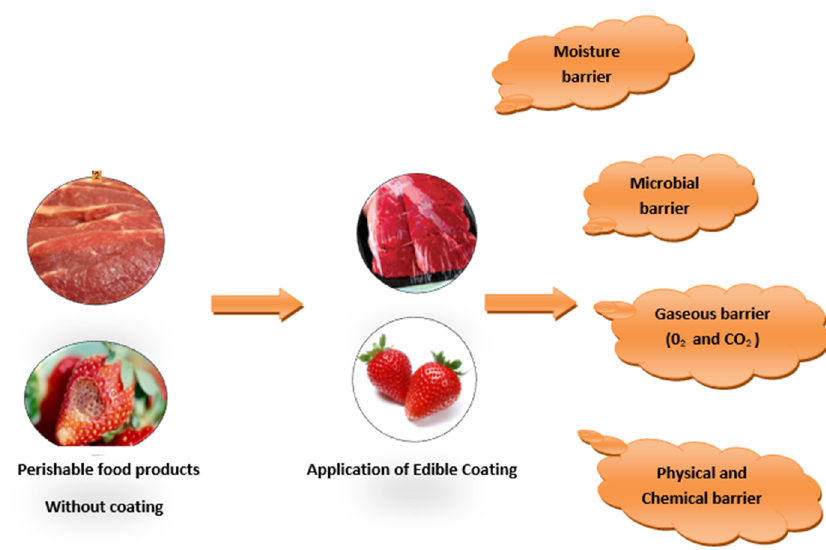
Figure 8. Application of edible coatings on perishable foods and its